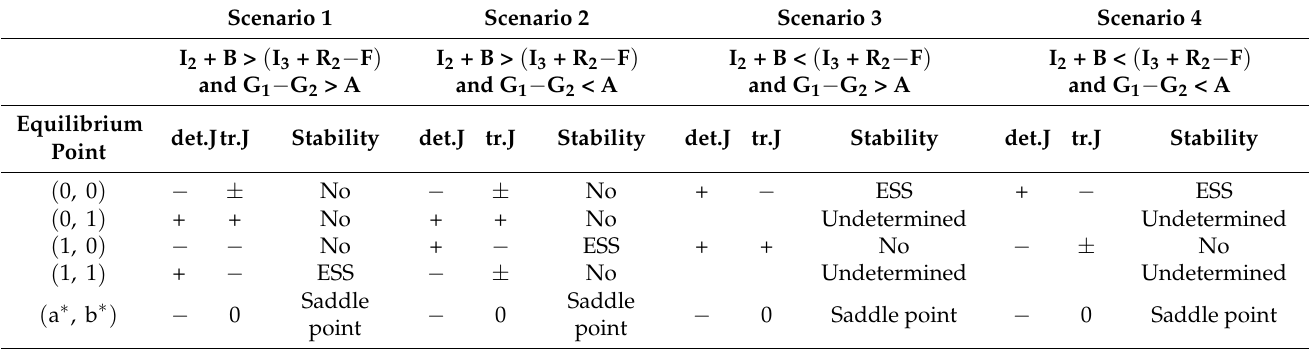
Table 7. Results of the local equilibrium stability of the game system between farmers and local